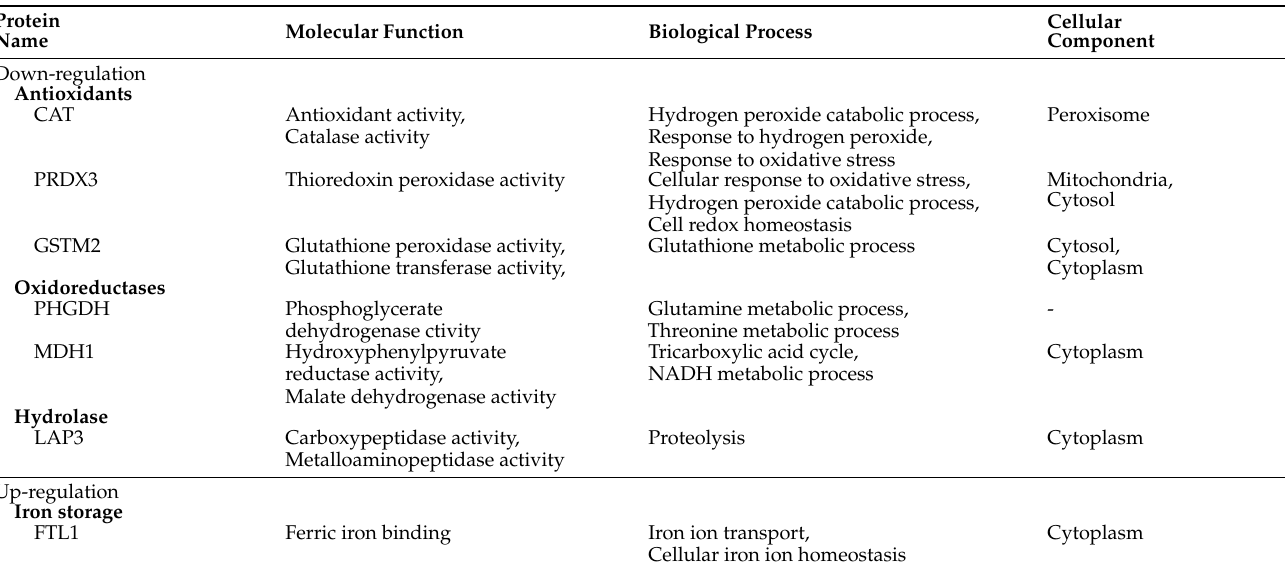
Table 4. Functional properties and location of epididymal adipose tissue proteins of 25-week-old CP that exhibited significant changes in their expression